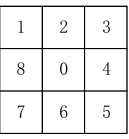
Figure 4. Schematic of the eight neighborhood.